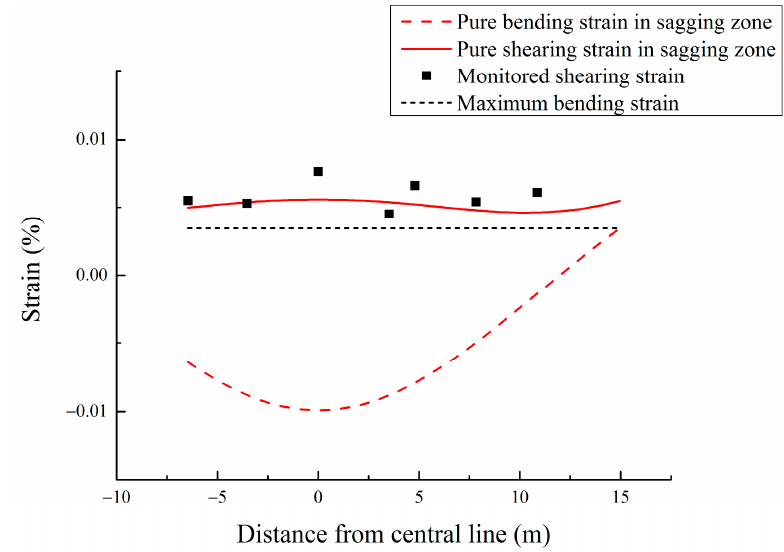
Figure 12. Bending strain and shear strain in the sagging zones .